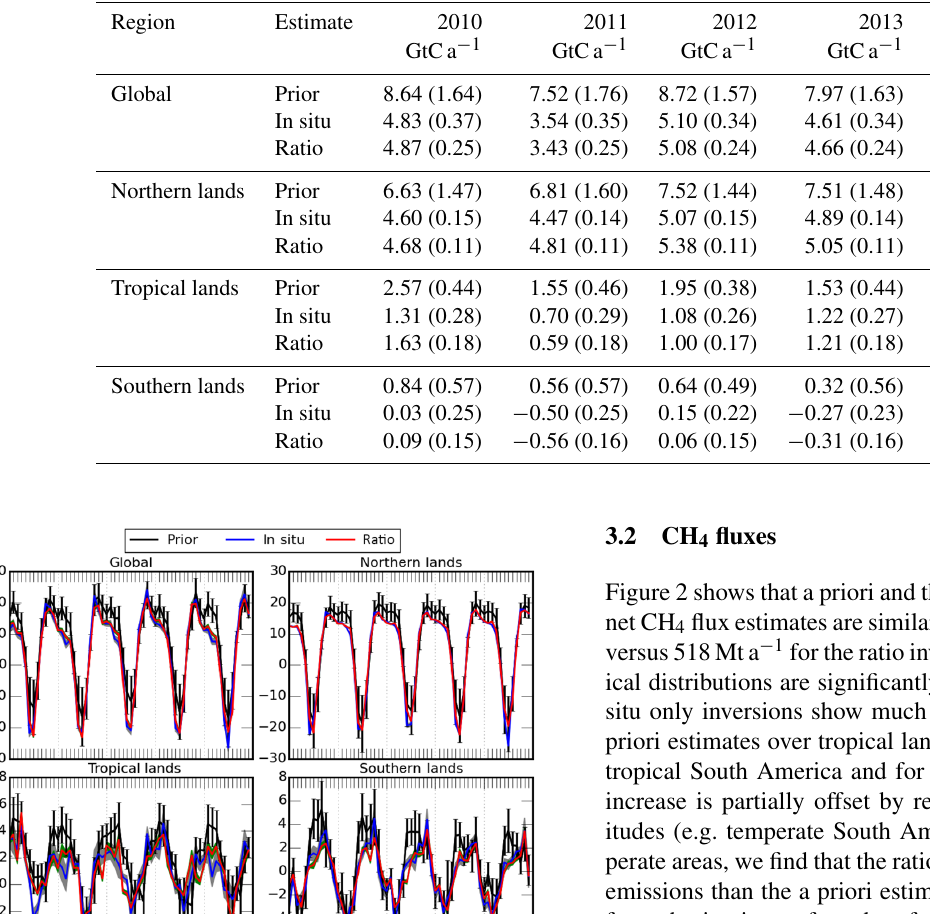
Table 1. A priori and a posterior estimates of the annual net CO 2 fluxes for 2010 to 2014 for the global and three contributing regions: (1) northern landmasses, (2) tropical landmasses, and (3) southern landmasses. Uncertainties of 1 σ are given in the brackets.